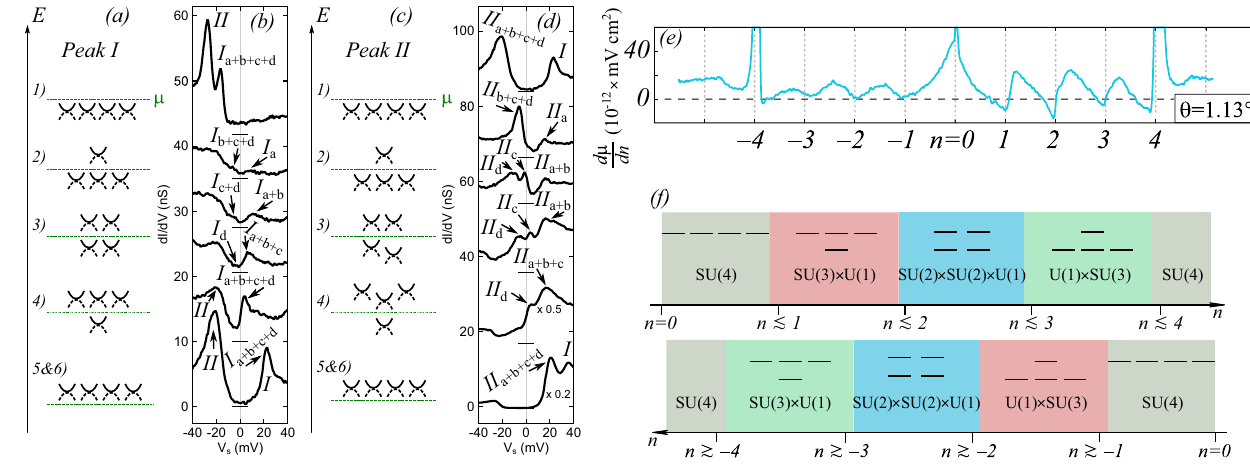
Fig. 1 The cascade of electronic transitions in twisted bilayer graphene. a – d the proposed splitting of the initially 4-fold (spin and valley) degenerate vH peak upon raising the electron fi lling n (panels ( a ), ( b )) and hole fi lling (panels ( c ), ( d )), and the corresponding STM data for twist angle of 1.06 ∘ , reproduced with permission from the authors of ref. 14 . The van Hove peaks in the conduction (valence) bands are labeled by I ( II ), and subscripts a,b,c,d label the 4 peak components. e Experimental data for inverse compressibility with seesaw features, interpreted as a cascade of phase transitions. Reproduced with permission from the authors of ref. 15 . The data are for twist angle θ = 1.13 ∘ , f The schematic phase diagram of TBG upon electron or hole doping, based on comparison between the theory and the STM data. Within our model, we obtained SU(3) × U(1) (U(1) × SU(3)) symmetry for both electron and hole doping at 1 < ∣ n ∣ < 2 (3 < ∣ n ∣ < 4), corresponding to 3-1 (1-3) splitting, but it is reduced to SU(2) × U(1) × U(1) (U(1) × U(1) × SU(2)) if there is an intermediate phase with 2-1-1 (1-1-2) splitting, as STM data for hole doping likely